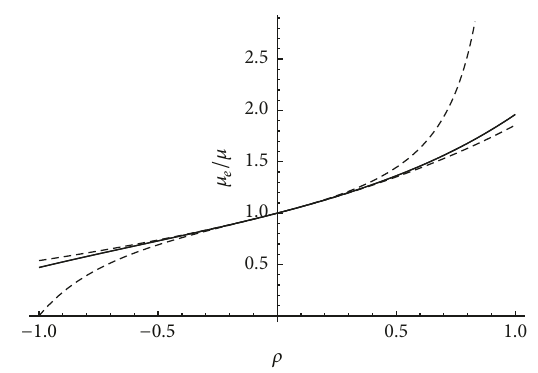
Figure 3: Dependence of the effective shear modulus for the hexagonal array on 𝜌 for 𝑓 = 0.3 . The designations of lines are the same as in Figure 1. Equation (85) and its polynomial expansion coincide (solid